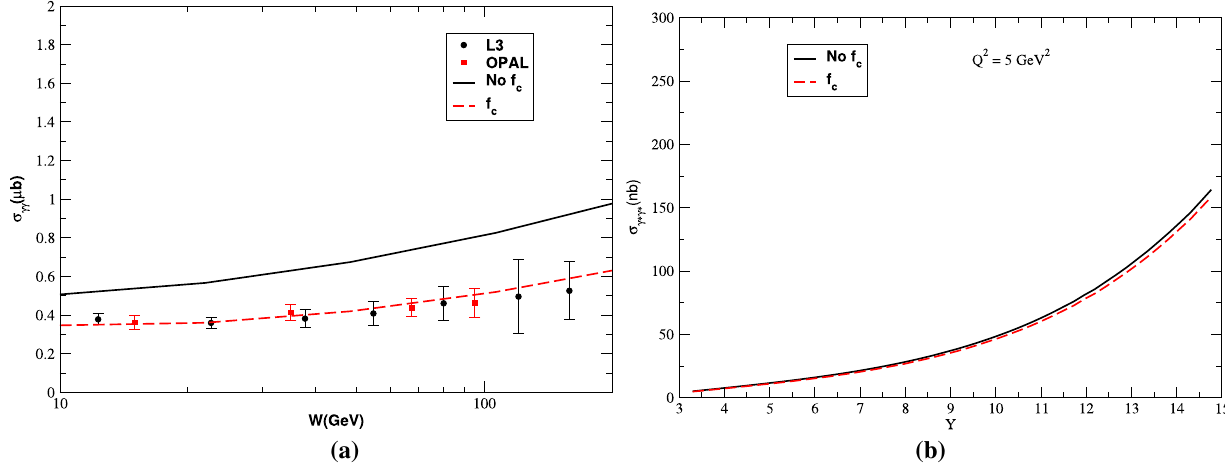
= Q 2 = 5 GeV 2 . Data 1 2